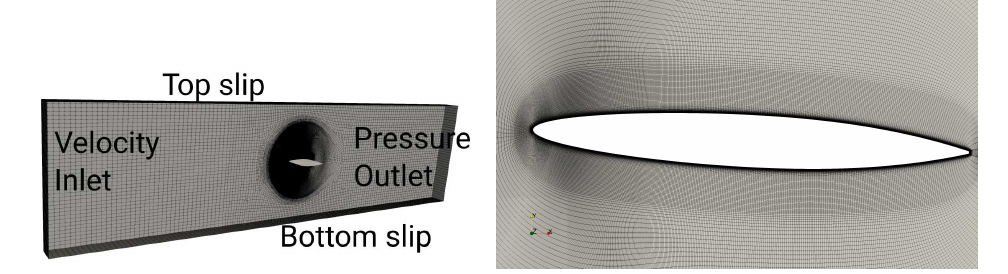
Figure 1. Simulation domain ( left ) and closer view of computational grids ( right ).